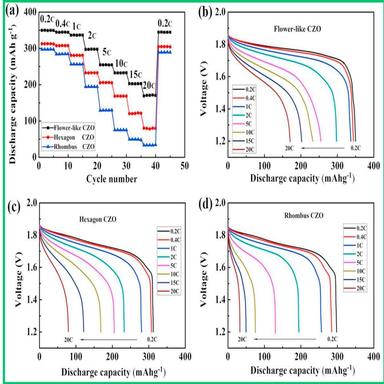
(a) Rate performance of the three calcium zincate electrodes at various discharge rates (0.2Ce20C); Typical discharge curves of the as-prepared calcium zincate electrodes at various discharge rates: (b) Flower-like calcium zincate, (c) Hexagon calcium zincate, (d) Rhombus calcium zincate.